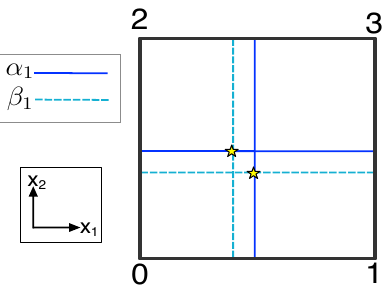
and β is determined by the intersections (la- 1 1 ( 〈 02 〉 ) β ( 〈 23 〉 ) in the definition of the cup 1 1